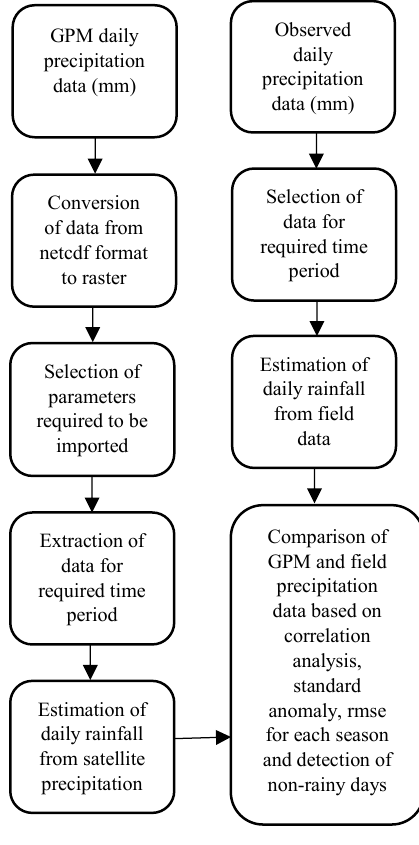
Figure 2. Flowchart of the methodology followed